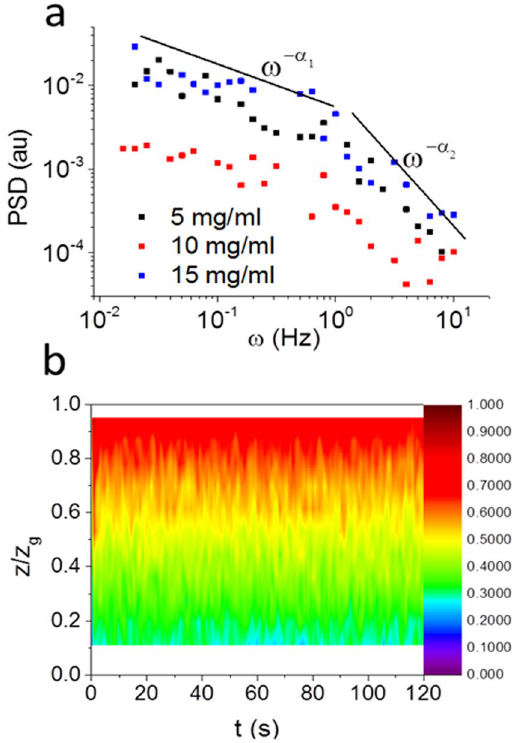
Figure 8. ( a ) Power spectral density (PSD) of the velocity fluctuations measured for three different concentrations of low salt DNA solutions, all with an applied shear rate of 60 s − 1 . Two separate power law behaviors are observed, at low frequencies ω ω α − ~ P ( ) 1 and at high frequencies ω ω α − ~ P ( ) 2 . ( b ) Colour map of shear normalized velocity as a function of the normalized distance across the rheometer gap and time after shear start up for a constant shear rate of 60 s − 1 . Intermittent fluctuations in the velocity are observed, although at much shorter times than in Fig.